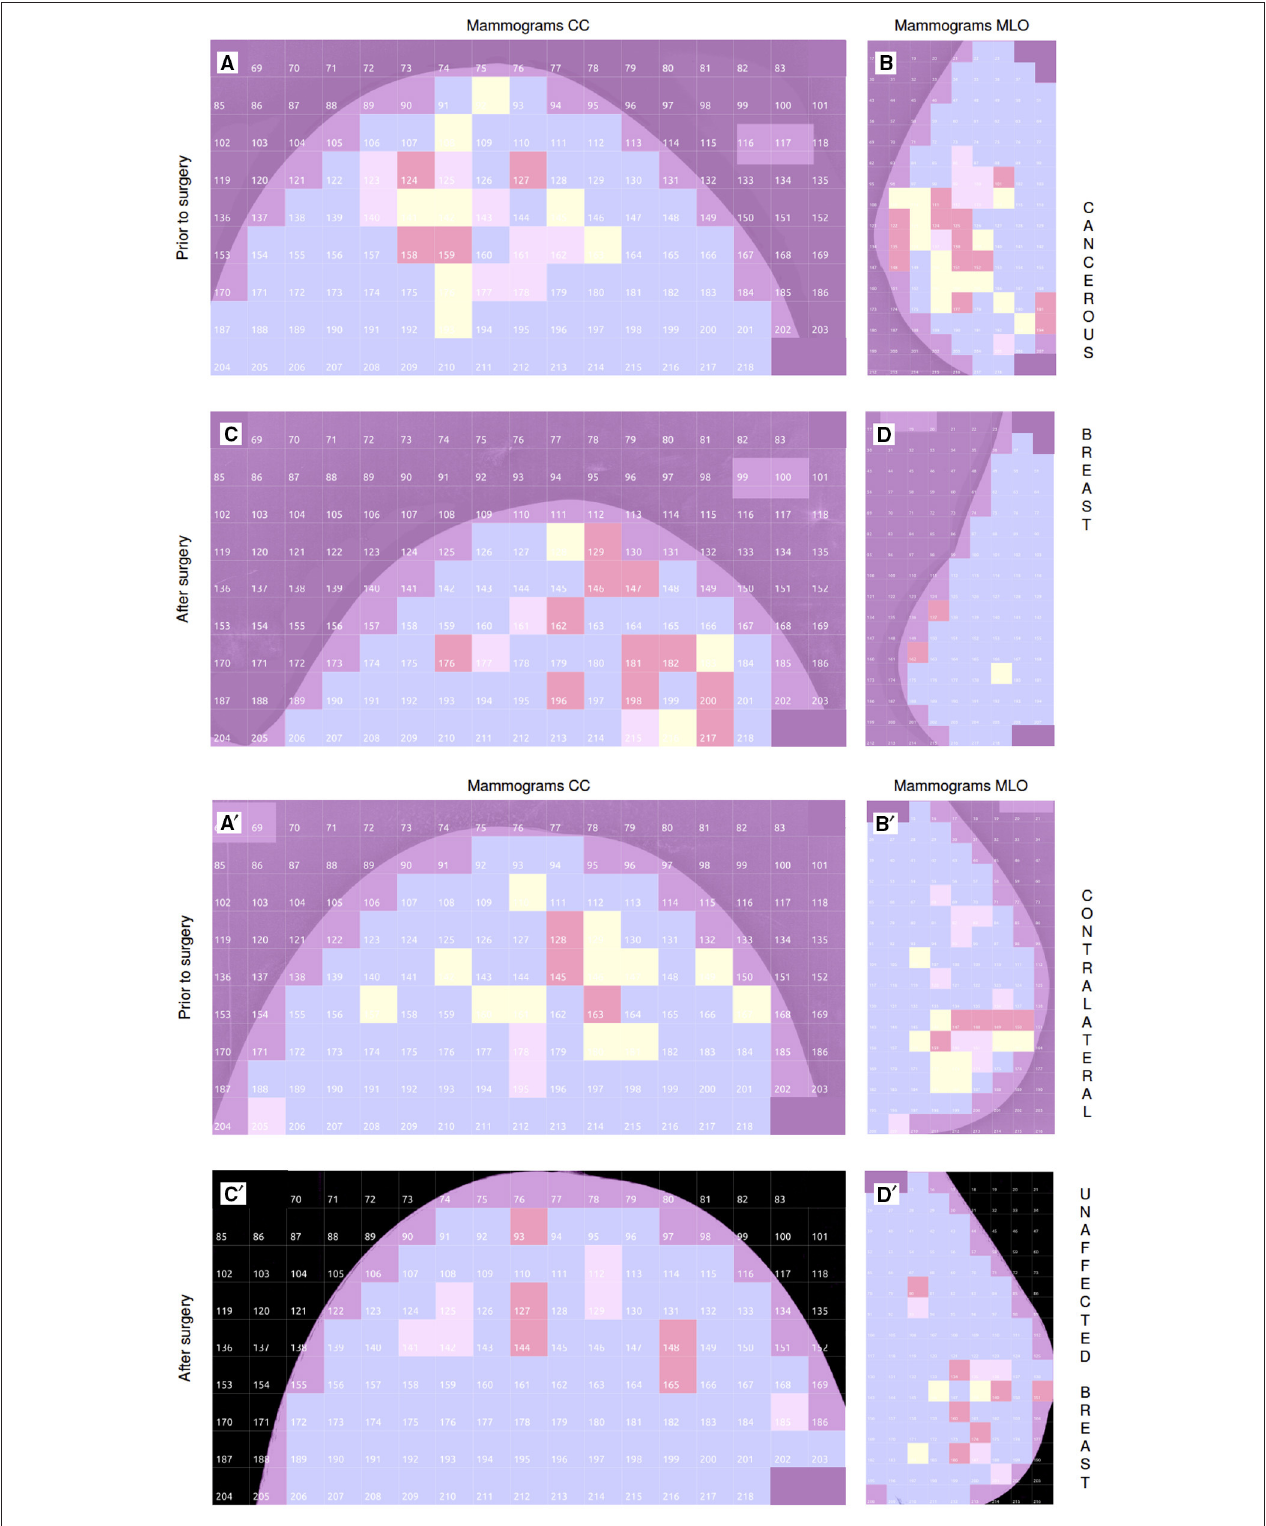
FIGURE 8 | Comparative multifractal analysis of the mammograms of the cancerous breast of patient 30 (age 54) before surgery (A,B) and 11 months after surgery (C,D). The color coding of the 256 × 256 pixel 2 squares in the CC (A,C) and MLO (B,D) mammogram views is the same as in Figures 1B,B ′ ,C,C ′ . (A ′ –D ′ ) Similar comparative multifractal analysis of the mammograms of the contralateral unaffected breast of patient 30.